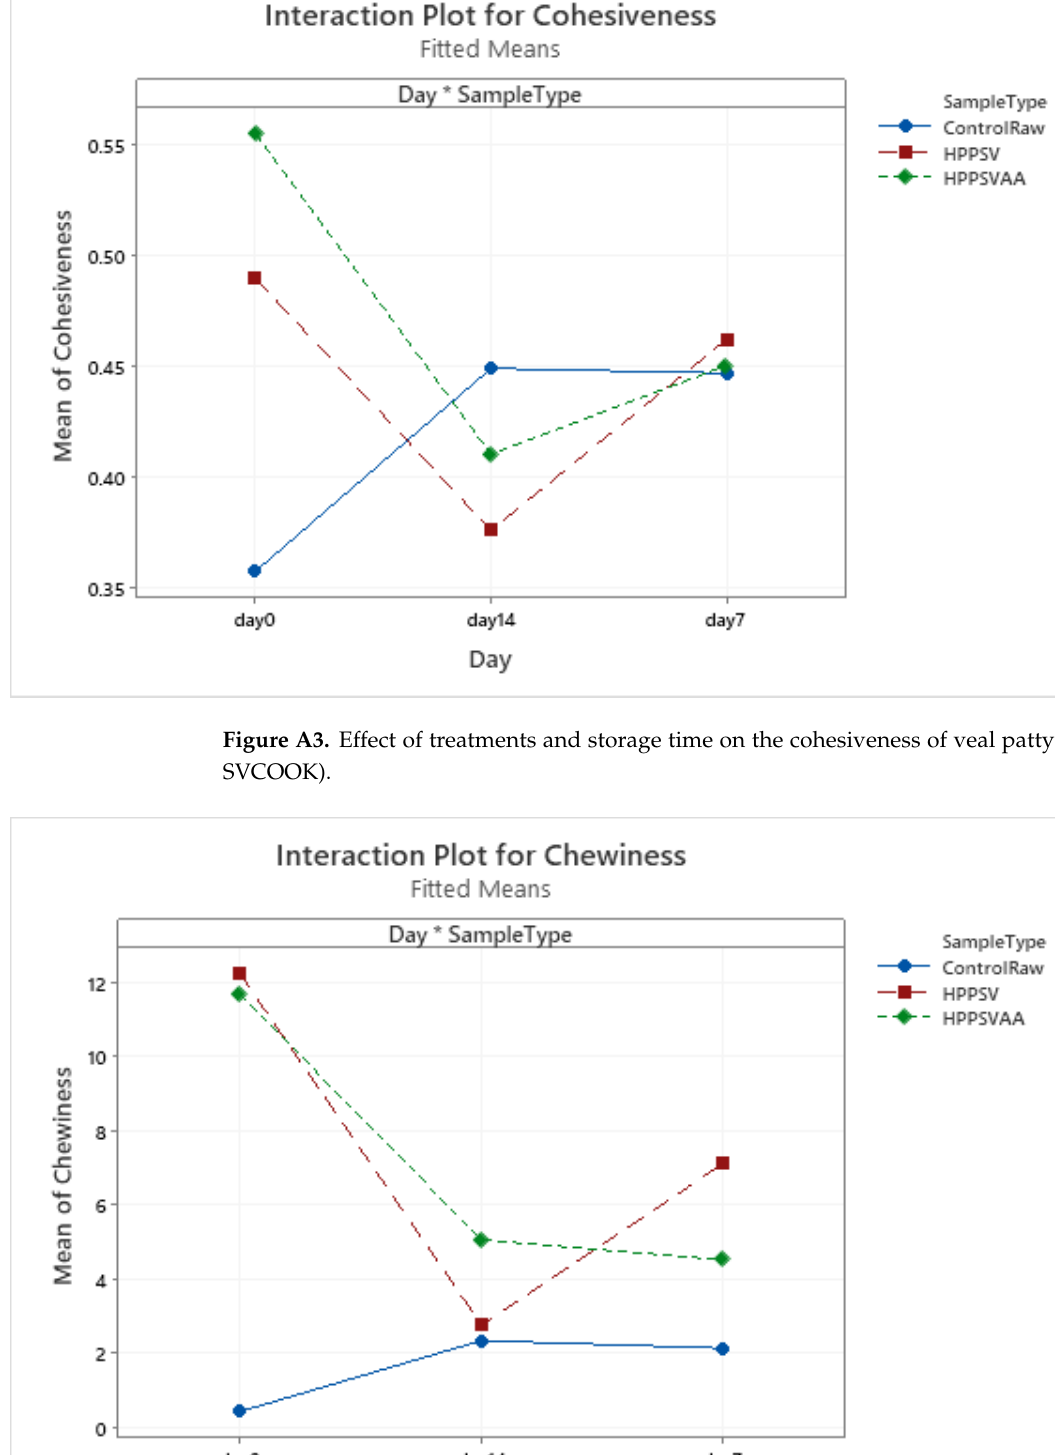
Figure A2. Effect of treatments and storage time on the springiness of veal patty (HPPSV: HPP- SVCOOK).